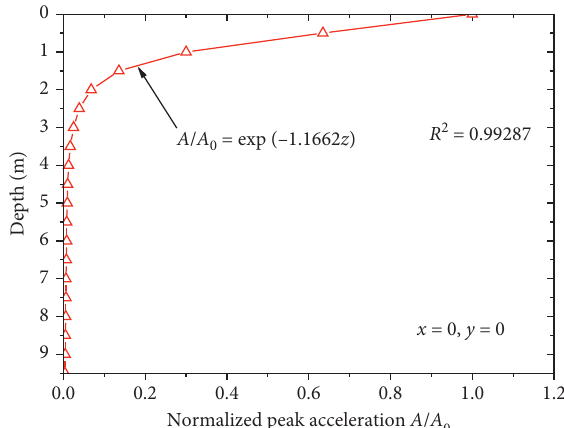
Figure 12: Peak acceleration of subgrade decaying with